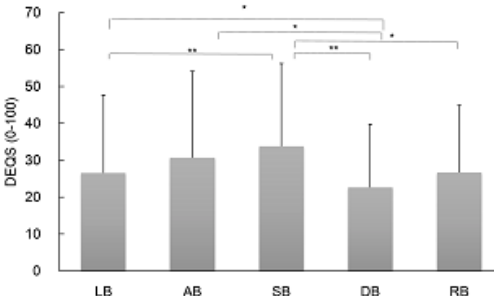
Figure 3. Results of fluorescein breakup patterns of Dry Eye Related Quality of Life Score. AB = area break; DB = dimple break; DEQS = Dry Eye Related Quality of Life Score; FBUPs = fluorescein breakup